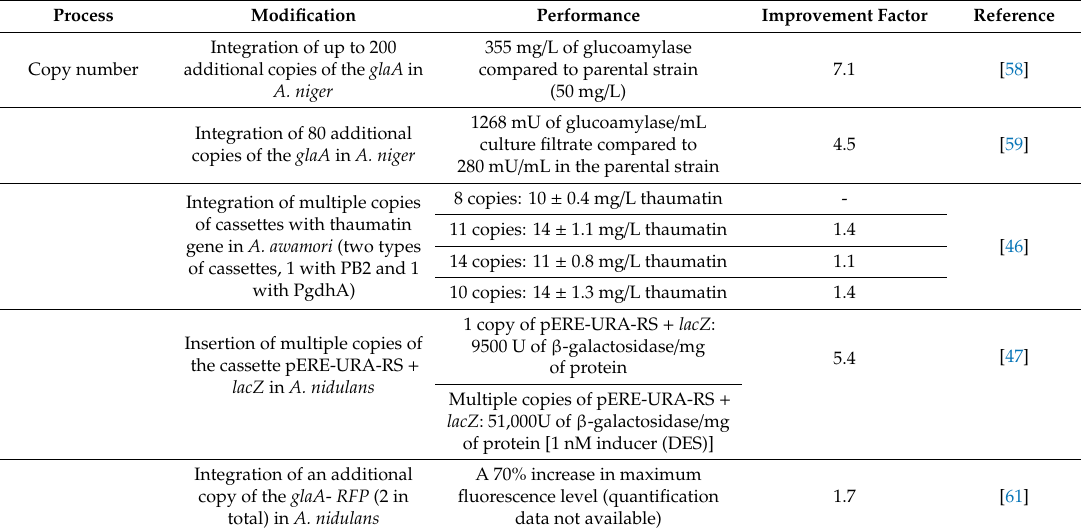
Table 3. Approaches for improving recombinant protein production through integration of multiple gene